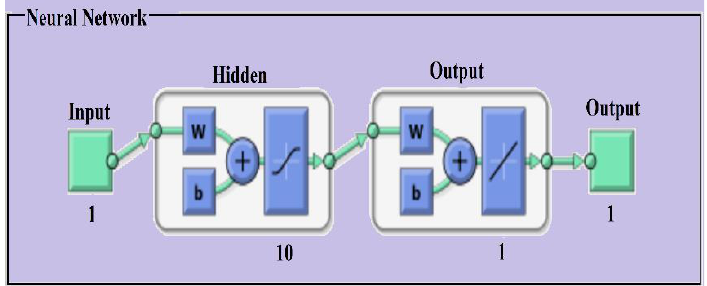
Figure 7. Structure of the neural network.